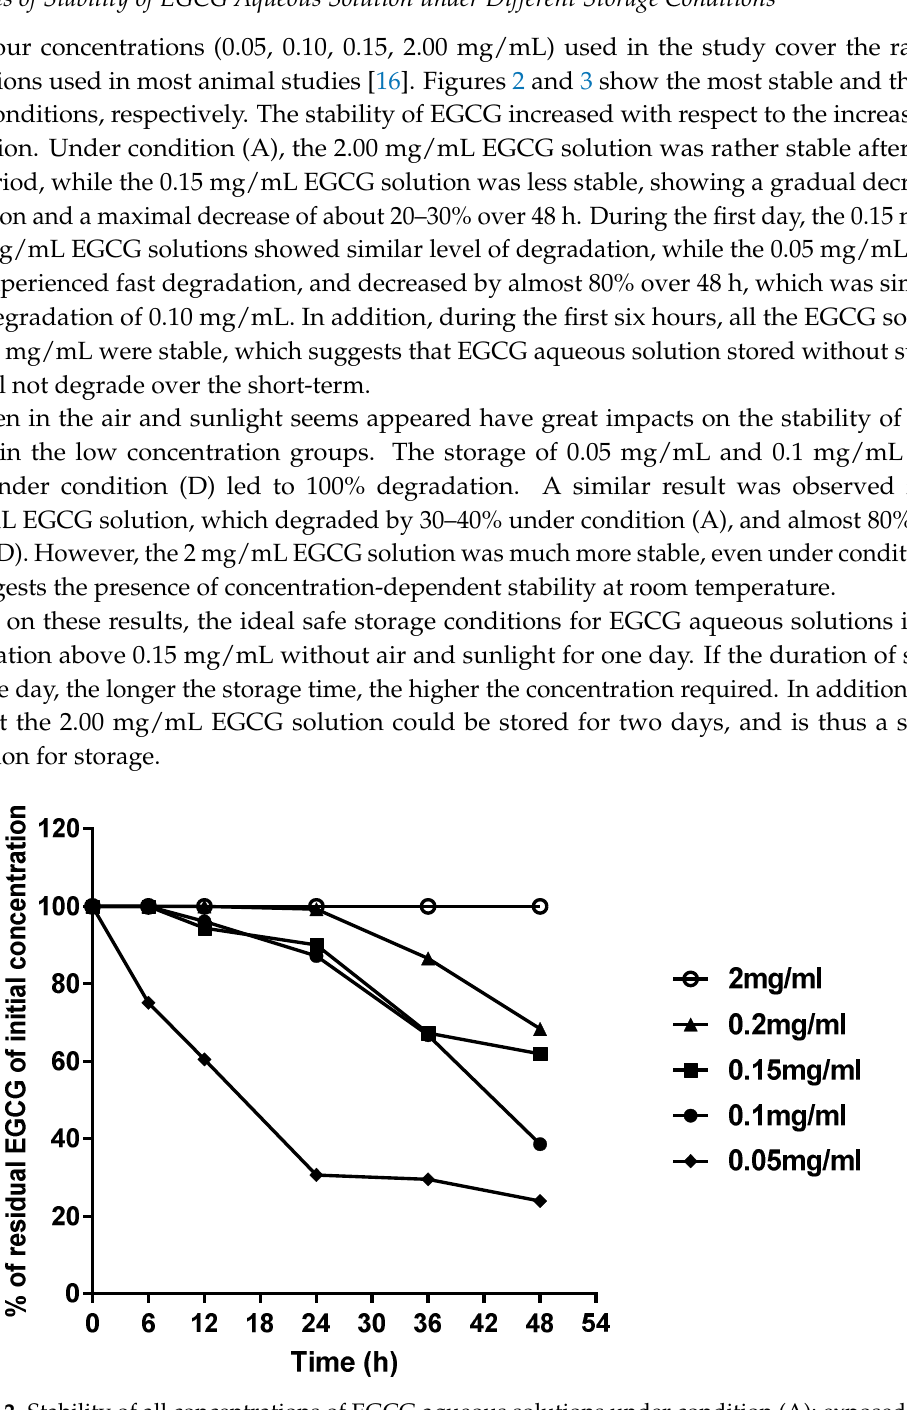
Table 2. Intra‐day/inter‐day accuracy and precision of EGCG in water.